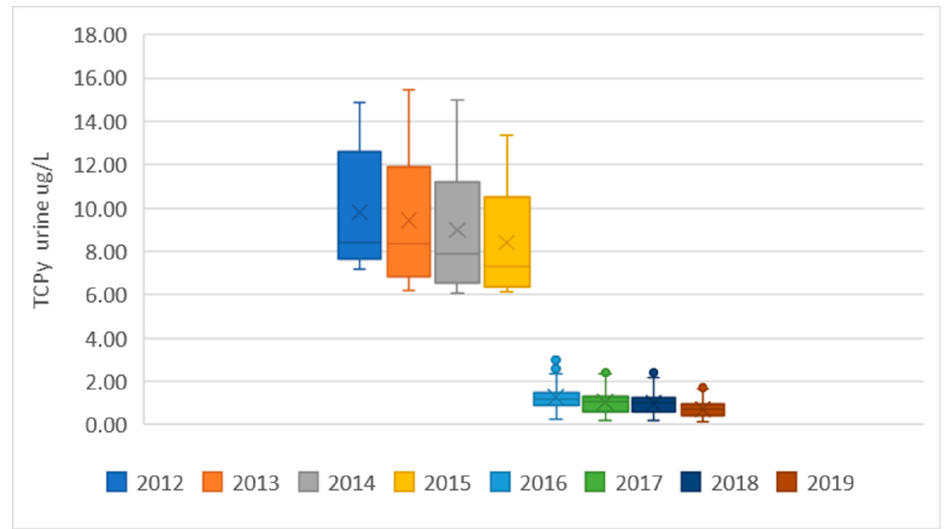
Figure 1. Predicted TCPy levels in EU consumers, estimated from chlorpyrifos levels in food extracted from the EU annual monitoring programs between 2012 and 2019. Data presented as box and whisker plots (see text for details).